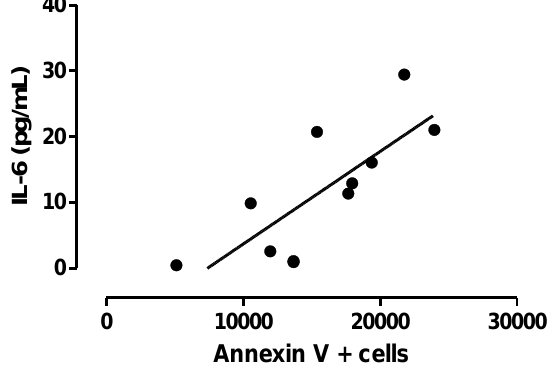
Figure 6. Correlation between the number of annexin V positive cells and IL-6 concentration. Spearman, r = 0.8519, p ≤ 0.001.